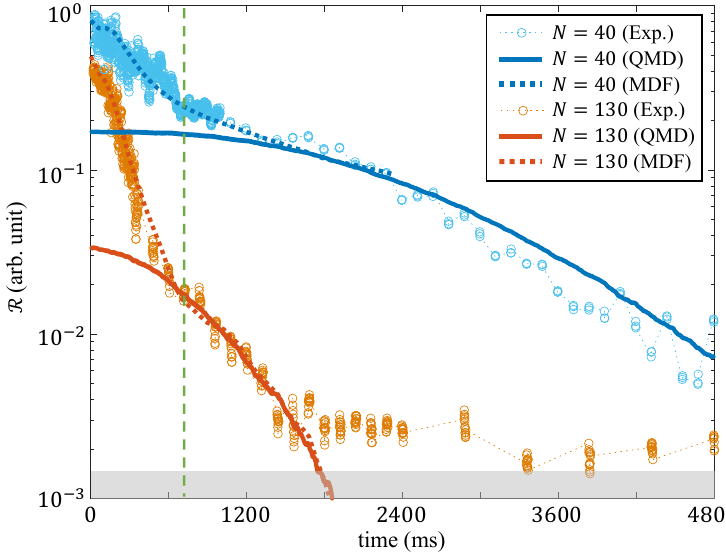
Figure 7: Relaxation characterized by the deviation of the oscillation period averaged MDF from its best-fit Gaussian distribution. The experimental measurements are shown with open circles in two colors for N = 40 and N = 130, respectively. These measurements are compared with the molecular dynamics simulation results, includ- ing both the calculated quasimomentum distributions (QMD) and the corresponding MDFs. In Stage I of evolution, the dynamics are well described by the evolution of the estimated MDF (dotted curves). As the system approaches the non-degenerate limit, the estimated MDF tends to coincide with the QMD (solid curves). In Stage II of evolution, the 1D gases relax towards a Gaussian MDF, which can be interpreted as a thermal equilibrium state. The molecular dynamics simulations agree nicely with the experimental data in Stage II. The vertical dashed line indicates the end of single-body dephasing and demarcates the two stages of relaxation. The shaded area indicates the noise